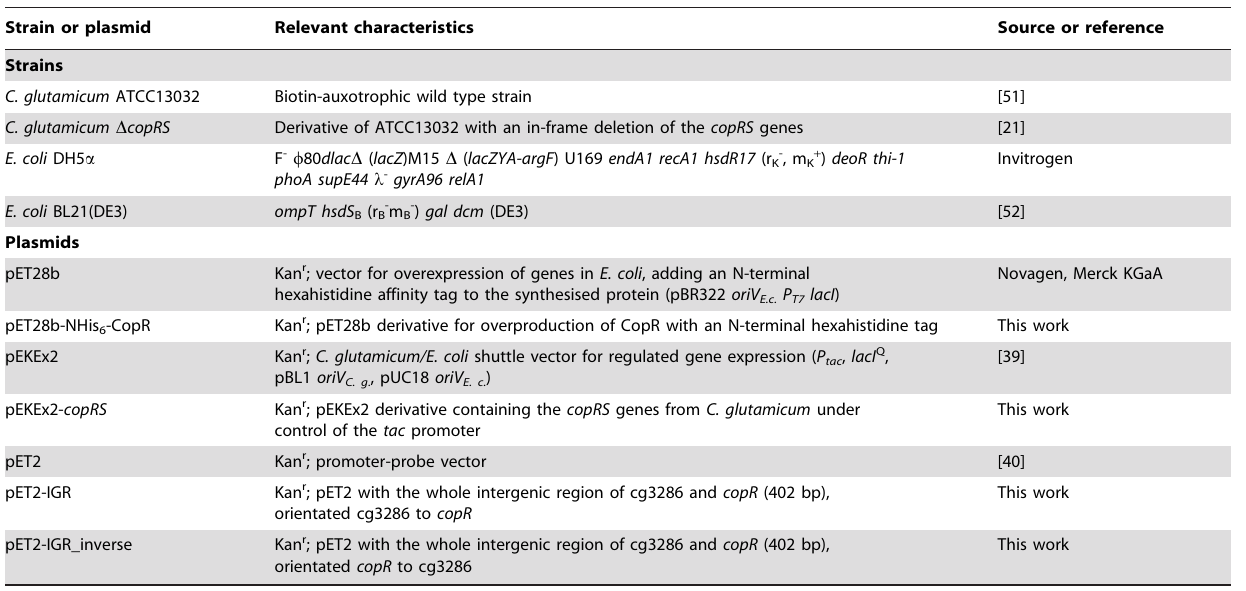
Table 3. Strains and plasmids used in this